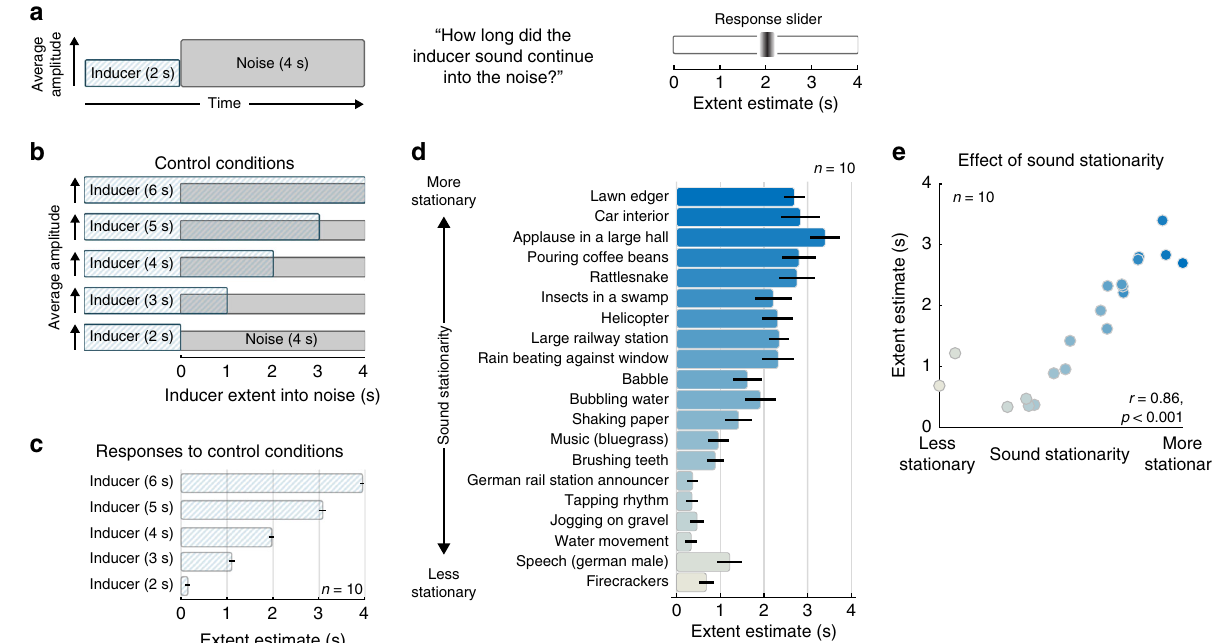
Fig. 4 Experiment 3 — estimation of the extent of illusory continuity. a Schematic of stimulus and task for main condition of Experiment 3. Inducer sounds used in the experiment were real-world sound recordings. Following the noise, participants adjusted a slider to indicate the extent over which they heard the inducer sound to continue into the noise. b Schematic of stimuli for control conditions, in which the inducer was higher in level than the noise and persisted for different amounts of time after the noise onset. c Mean estimated persistence for control conditions, pooled across inducer sounds. d Mean estimated extent of persistence for main condition of Experiment 3, plotted separately for different inducer sounds. Sounds are sorted by their stationarity. Bar color denotes inducer sound stationarity. e Mean extent estimate plotted vs. inducer sound stationarity (also denoted by the dot color, to aid comparison to panel d). Error bars plot